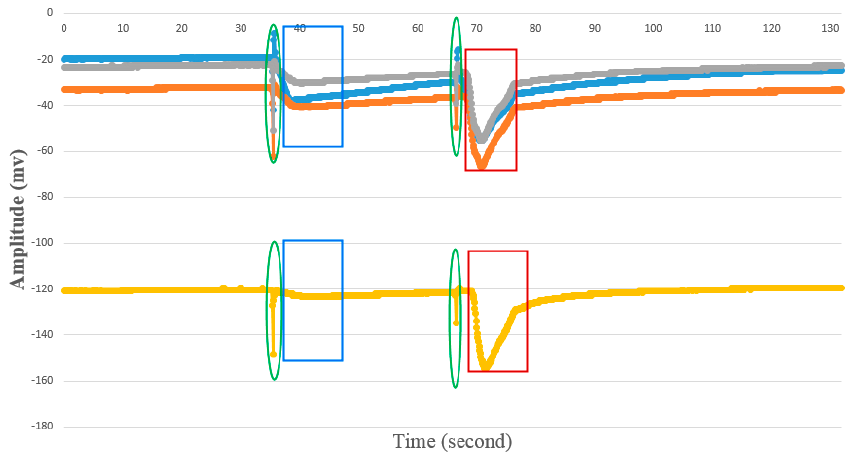
Figure 8. Electrical signals induced by electrical stimulation. Green circle indicates artifact, blue rectangle indicates sub threshold response, and red rectangle indicates AP.